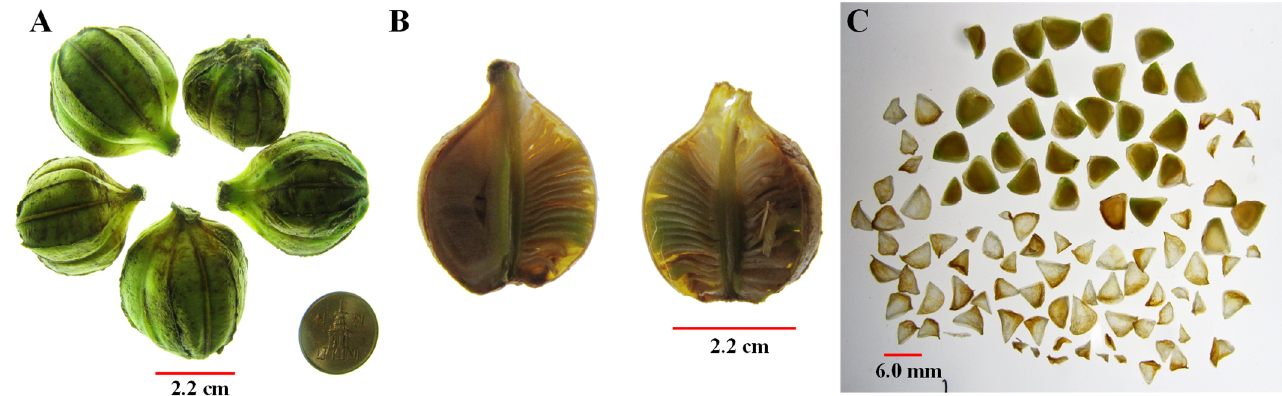
Figure 1. Morphology of fruits from the cross of L. hansonii × L. brownii var. colchesteri. ( A ): Fruits.